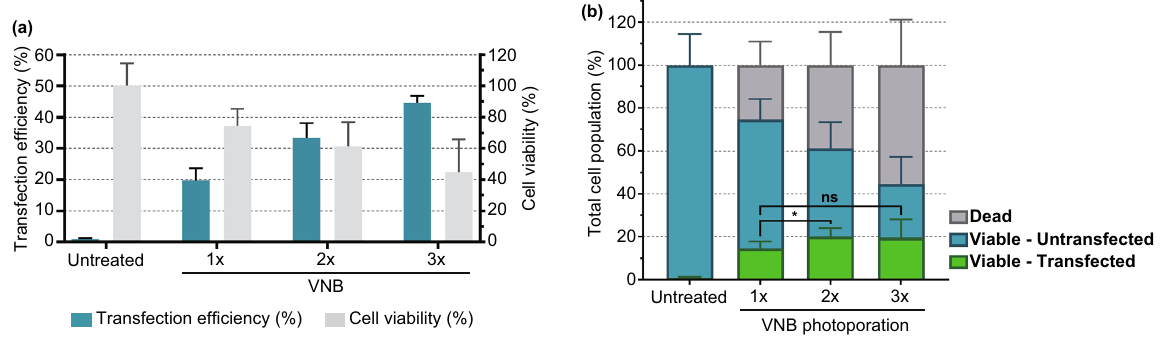
Fig. 6 Effect of multiple consecutive VNB photoporation treatments on mRNA transfection efficiency of Jurkat cells. a Transfection efficiencies represent the percentage of eGFP-positive cells, and cell viability values were calculated relatively to the untreated control. b Viable/transfected, viable/untransfected and dead cell populations were calculated for the different conditions ( n ≥ 3, One-way ANOVA with Tukey’s multiple com- parison test, * p < .05, ns =